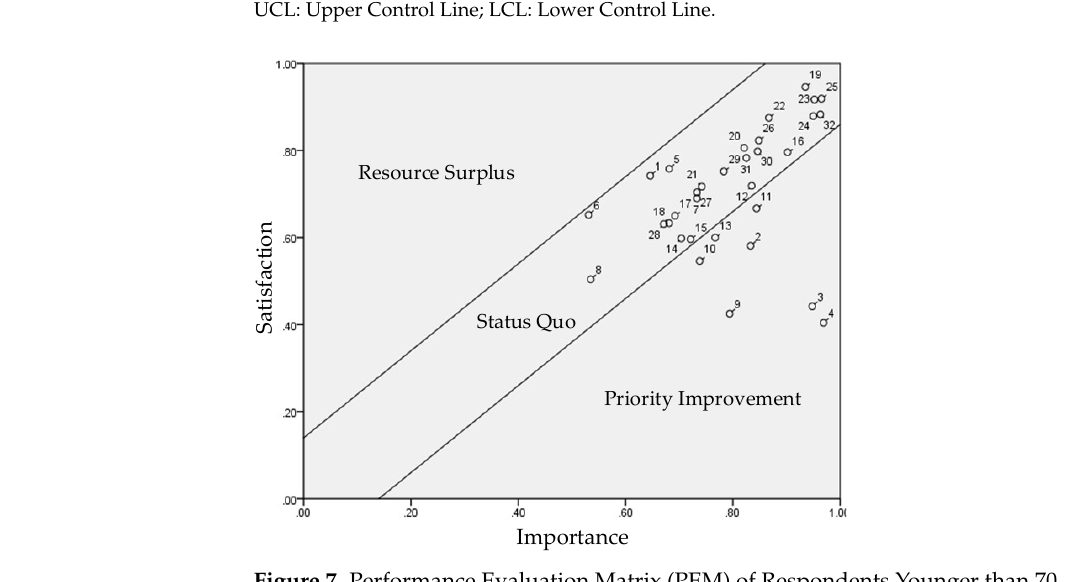
Table 8. Index Values for Age in the Performance Evaluation Matrix (PEM).